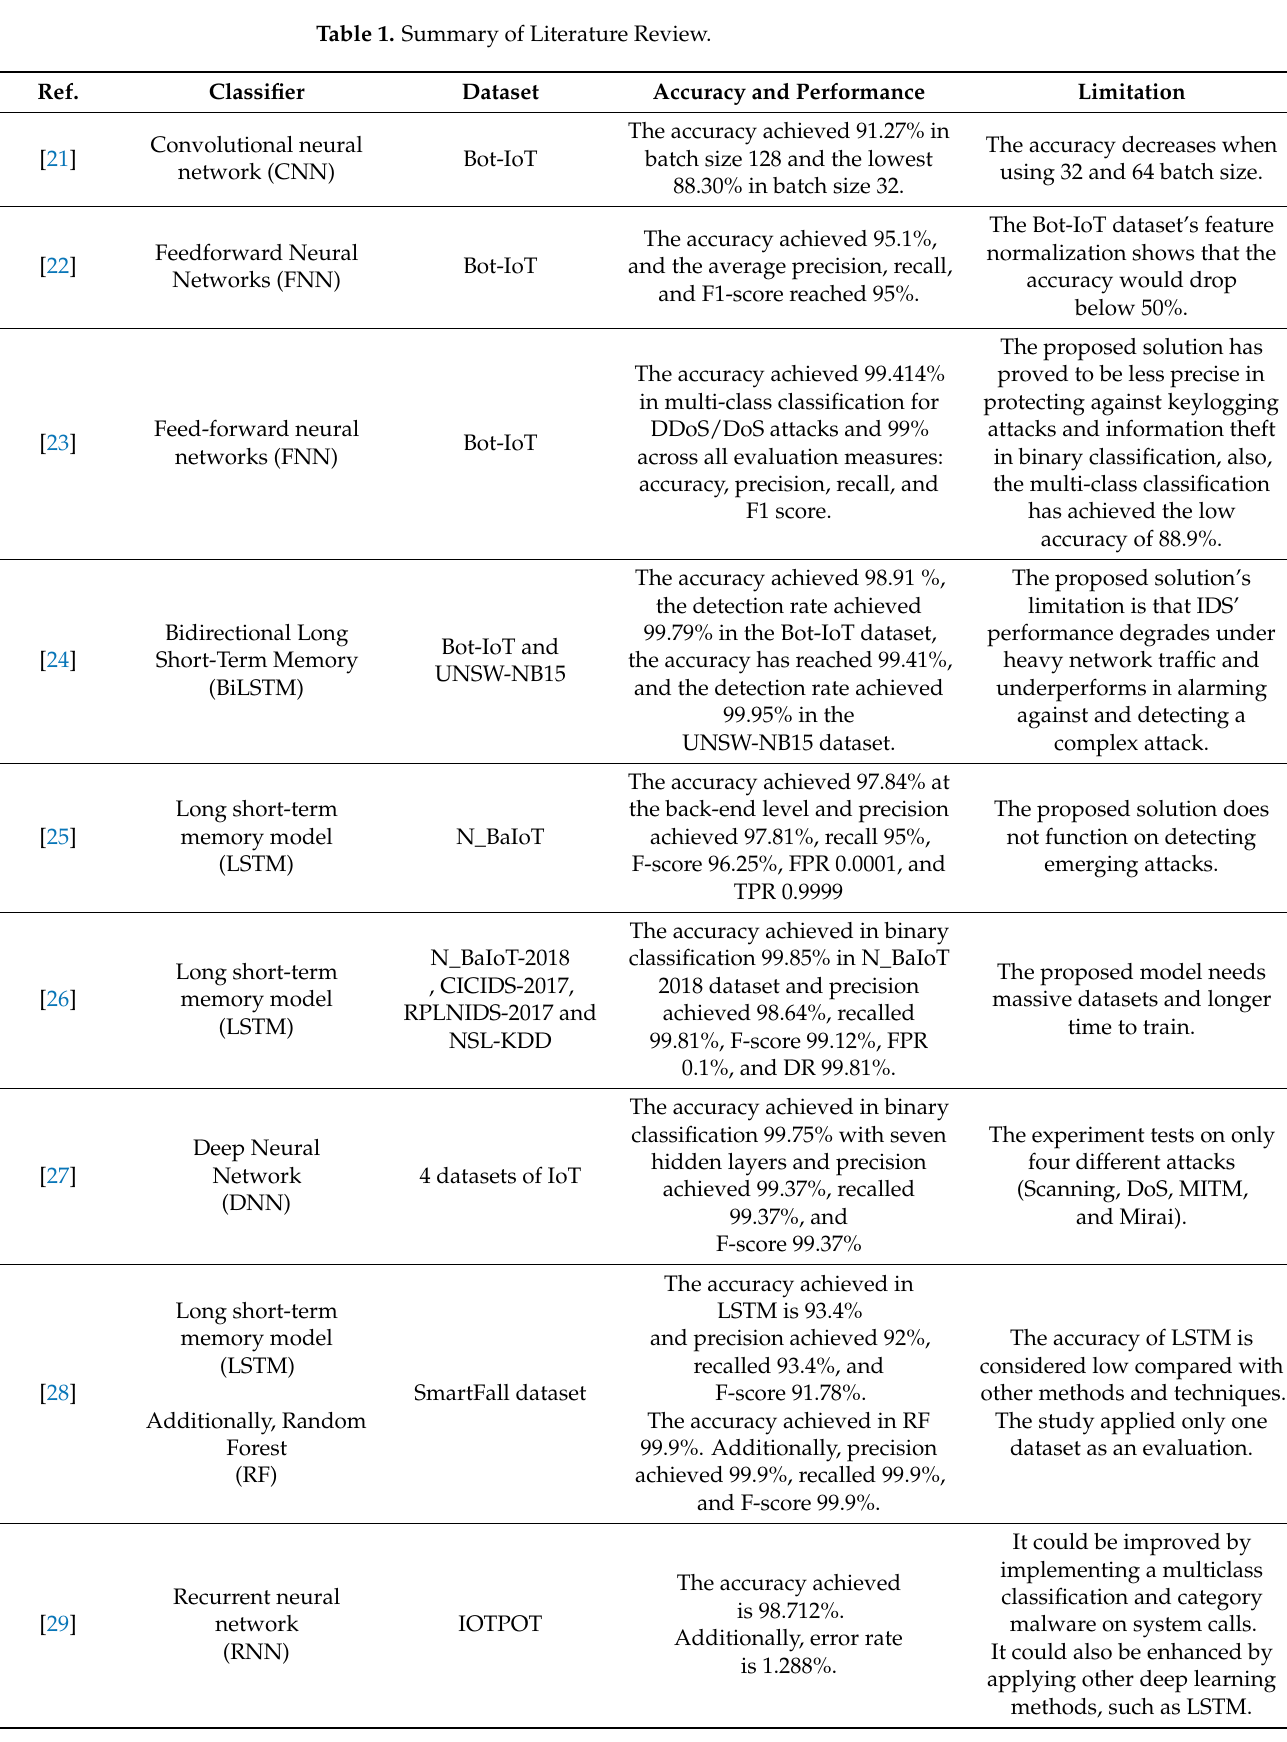
Table 1. Summary of Literature